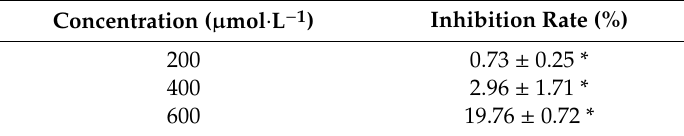
Table 2. Inhibition rates of catechin against A549 cells proliferation.